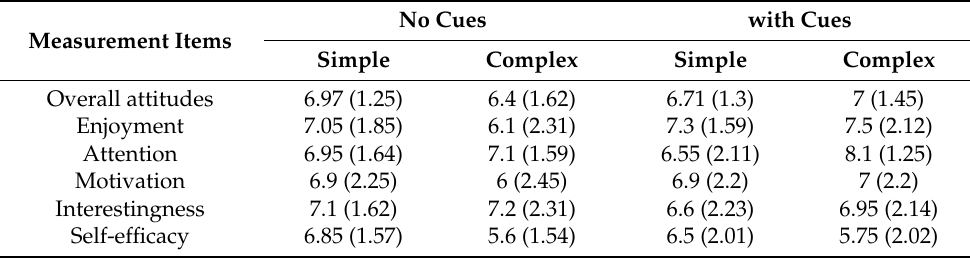
Table 4. Means and (standard deviations) of subjective-rating measurements as a function of all experimental